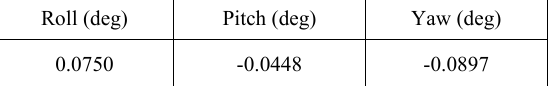
Table 6. Statistics of Orientation parameter from GPS/IMU